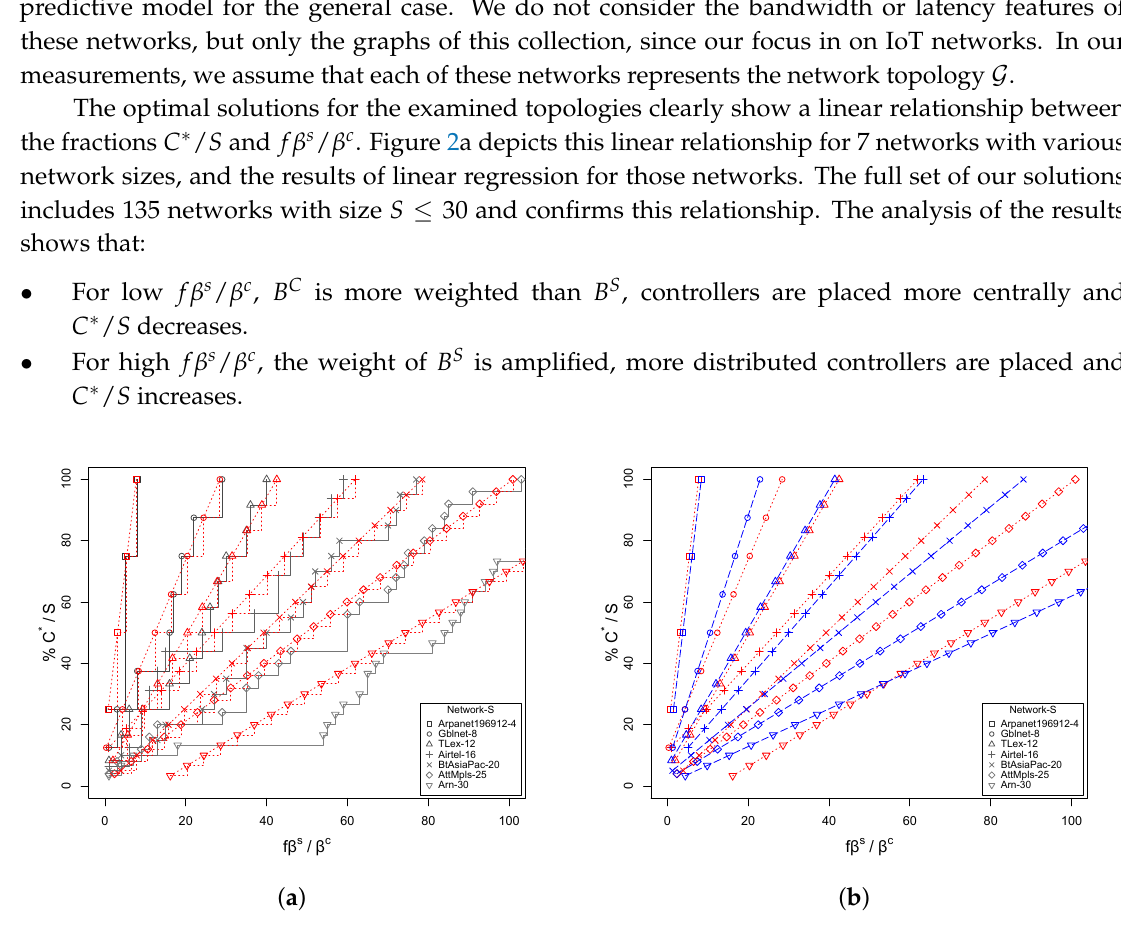
Figure 2. Linear regression between C ∗ / S and f β s / β c for seven example topologies. Topology names, as listed in the Internet Topology Zoo collection, are suffixed by their size S . ( a ) Solid gray lines depict the relationship between C ∗ / S and f β s / β c . Dashed red lines depict the linear regression of this relationship (the stairstep lines depict the percentage corresponding to the integer number of controllers). ( b ) Dashed red lines depict the linear regression of the relationship between C ∗ / S and f β s / β c , as before. Blue dashed lines depict the linear models extracted by Equation